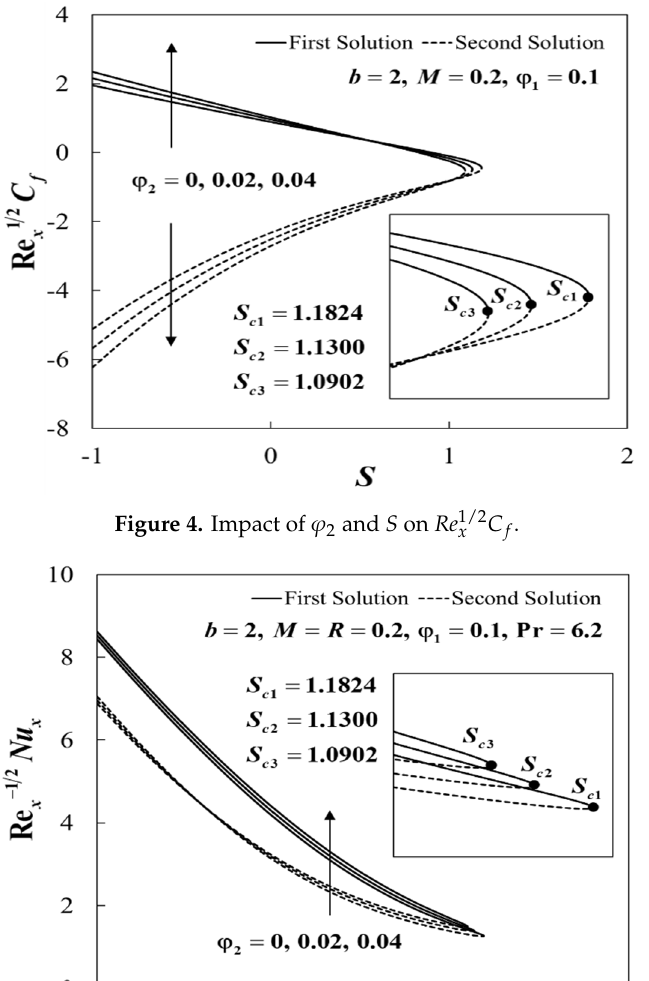
Figure 5. Impact of 𝜑 (cid:2870) and 𝑆 on 𝑅𝑒 (cid:3051)(cid:2879)(cid:2869)/(cid:2870) 𝑁 𝑢 (cid:3051) .